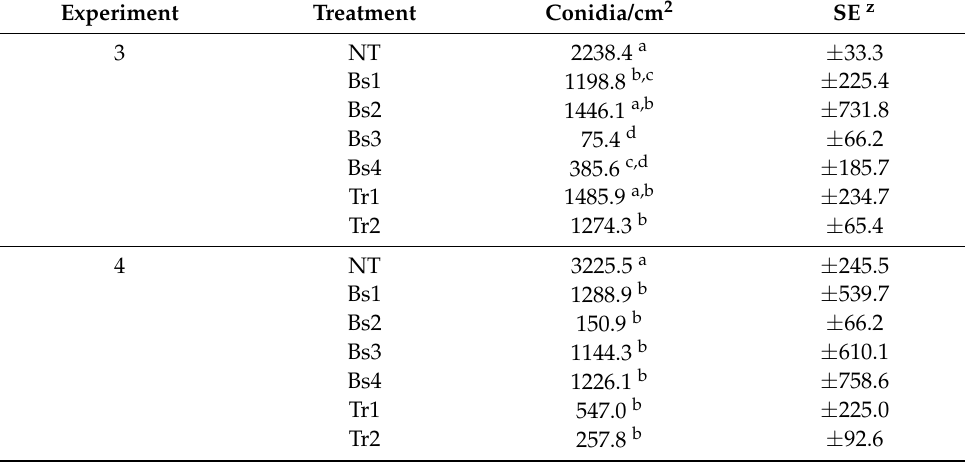
Table 1. Effect of preventative applications of biological control agents (BCAs) on conidia production of Stemphylium vesicarium . BCAs used were Bacillus subtilis strains (Bs1, Bs2, Bs3, Bs4) and Trichoderma spp. strains (Tr1, Tr2). NT: non-treated control. Means with the same letter in each experiment are not significantly different according to Fisher’s protected least significant difference test ( p <